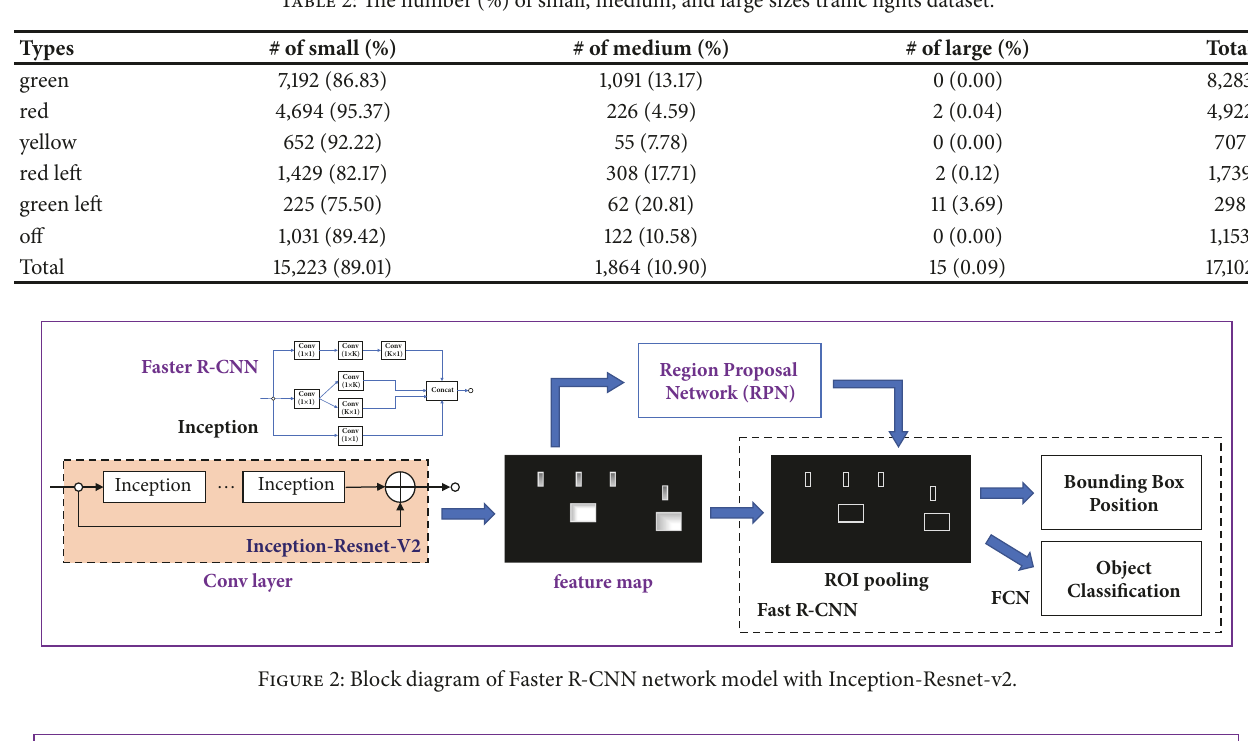
Table 2: The number (%) of small, medium, and large sizes traffic lights dataset.